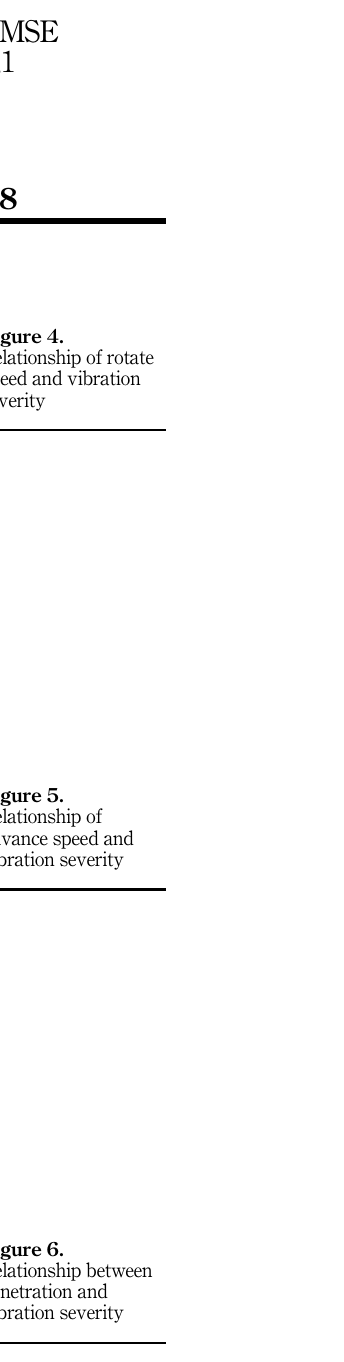
Figure 4. Relationship of rotate speed and vibration severity